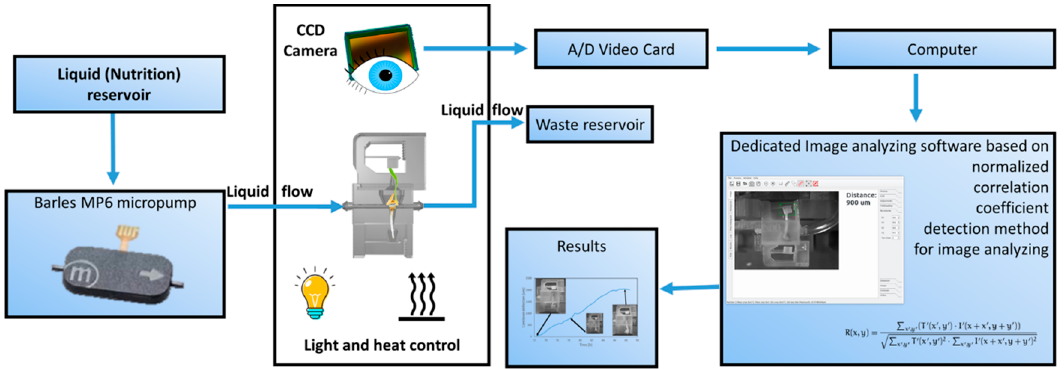
Figure 3. Scheme of the system for micrpot planting with main components and image analyze